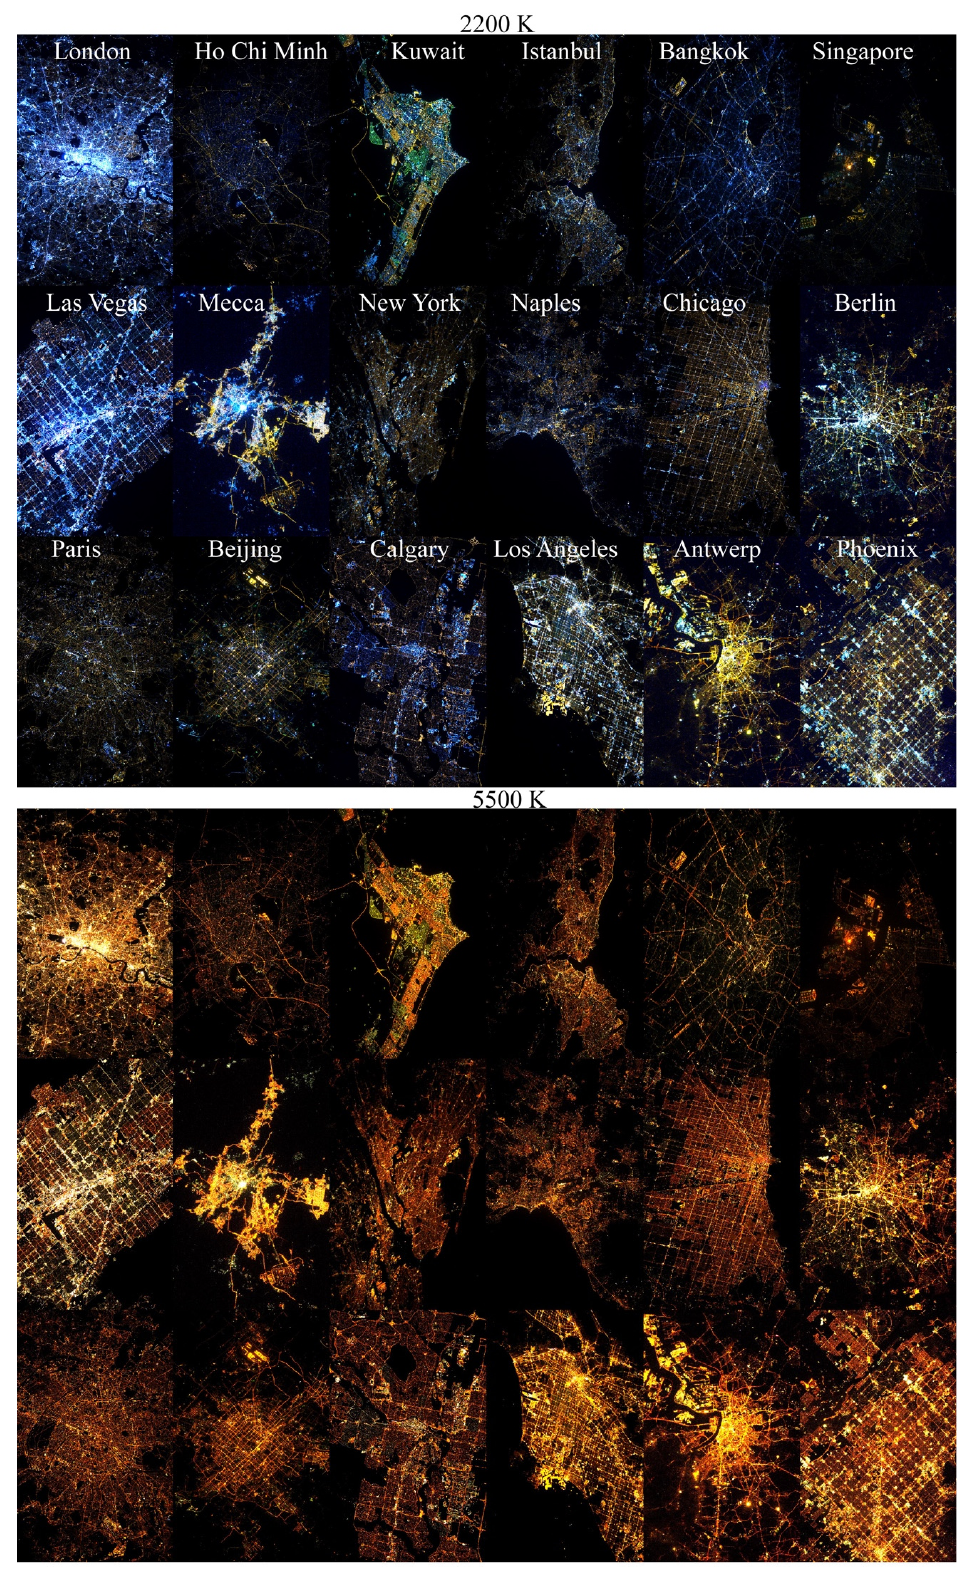
Figure 5. Color temperature-calibrated mosaics of 18 cities. The 2200 K mosaic corresponds to the color temperature of a high-pressure Sodium lamp while the 5500 K mosaic corresponds to natural daylight, showing the preponderance of warm spectrum light